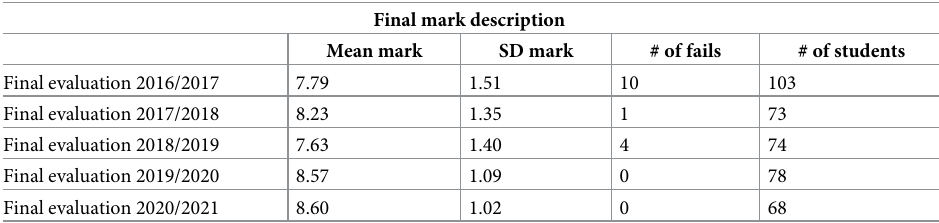
Table 1. Description of the data. SD stands for standard